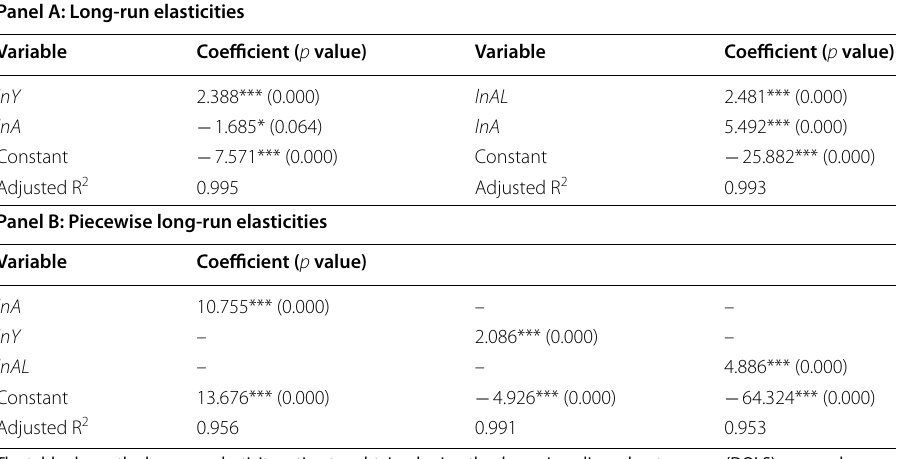
Table 3 Long-run